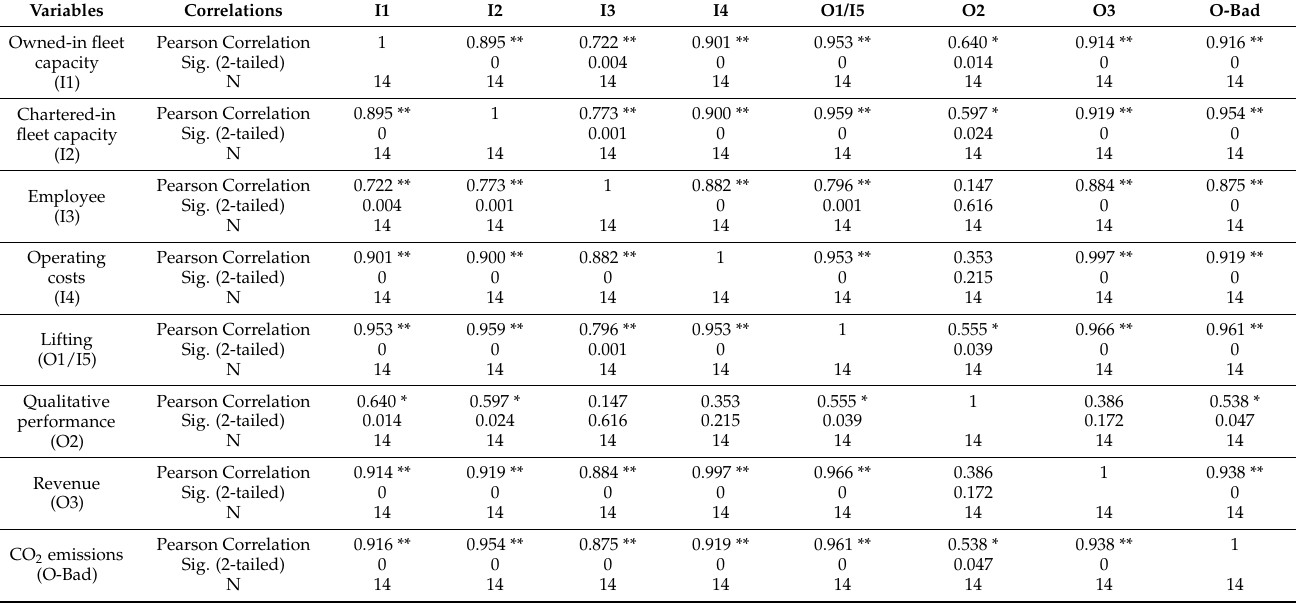
Table A4. The correlation matrix of input and output variables of the DEA